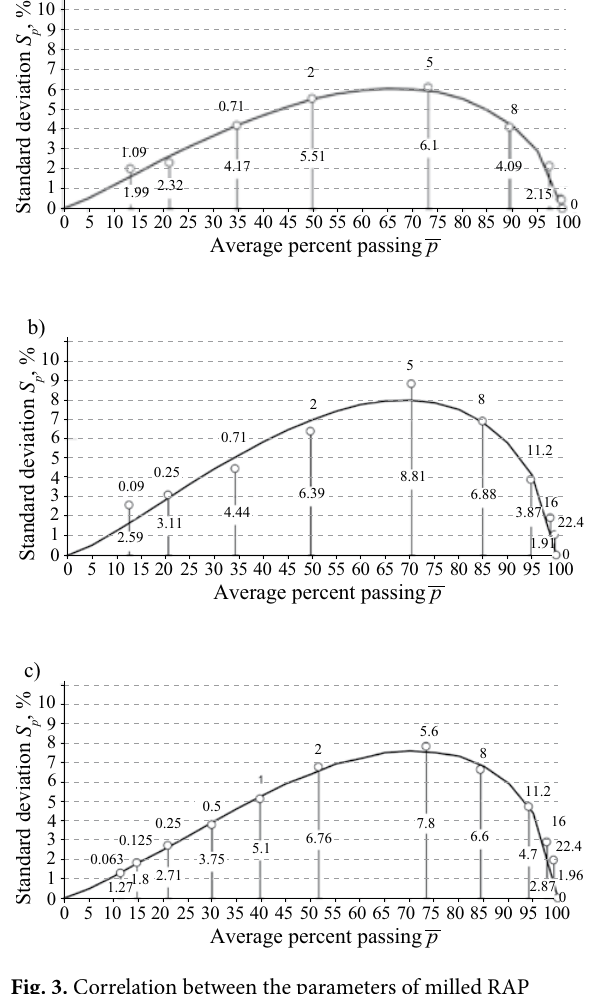
Fig. 3. Correlation between the parameters of milled RAP aggregate gradation variation ( s p ) and position ( p ) determined